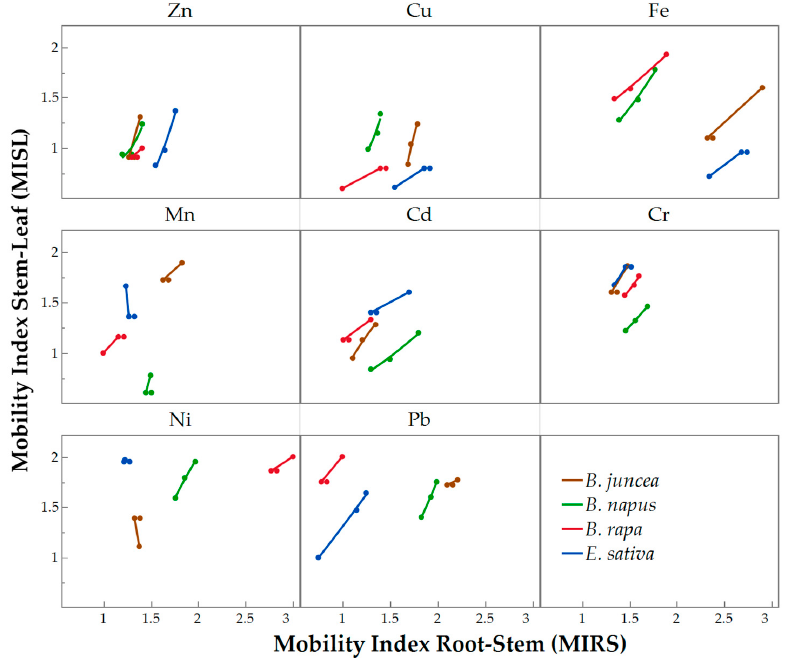
Figure 3. Relationships between mobility index at root ‐ stem (MIRS) and mobility index at stem ‐ leaf (MISL) of crops for heavy metals concentrations (mg kg − 1 dry weight). (MISL) of crops for heavy metals concentrations (mg kg − 1 dry